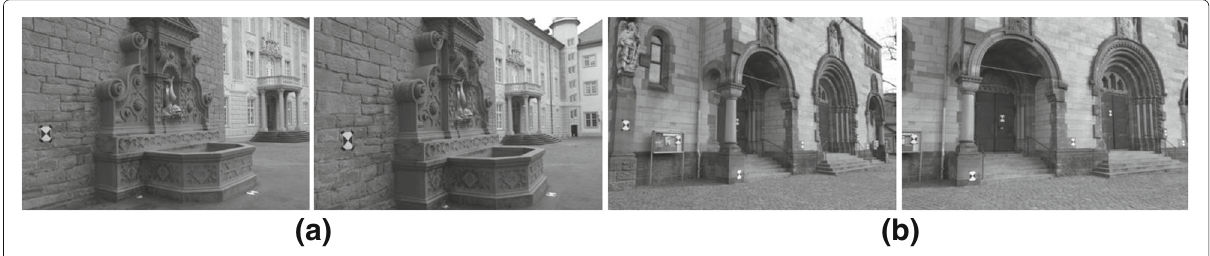
Fig. 4 Two stereo pairs used for parameter selection for the proposed